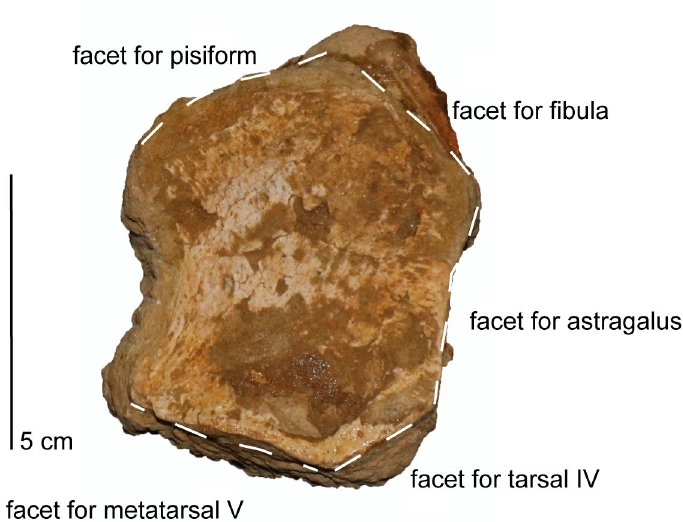
Fig 24. Calcaneum of Cardiocorax mukulu (MGUAN PA278) in ventral view facets